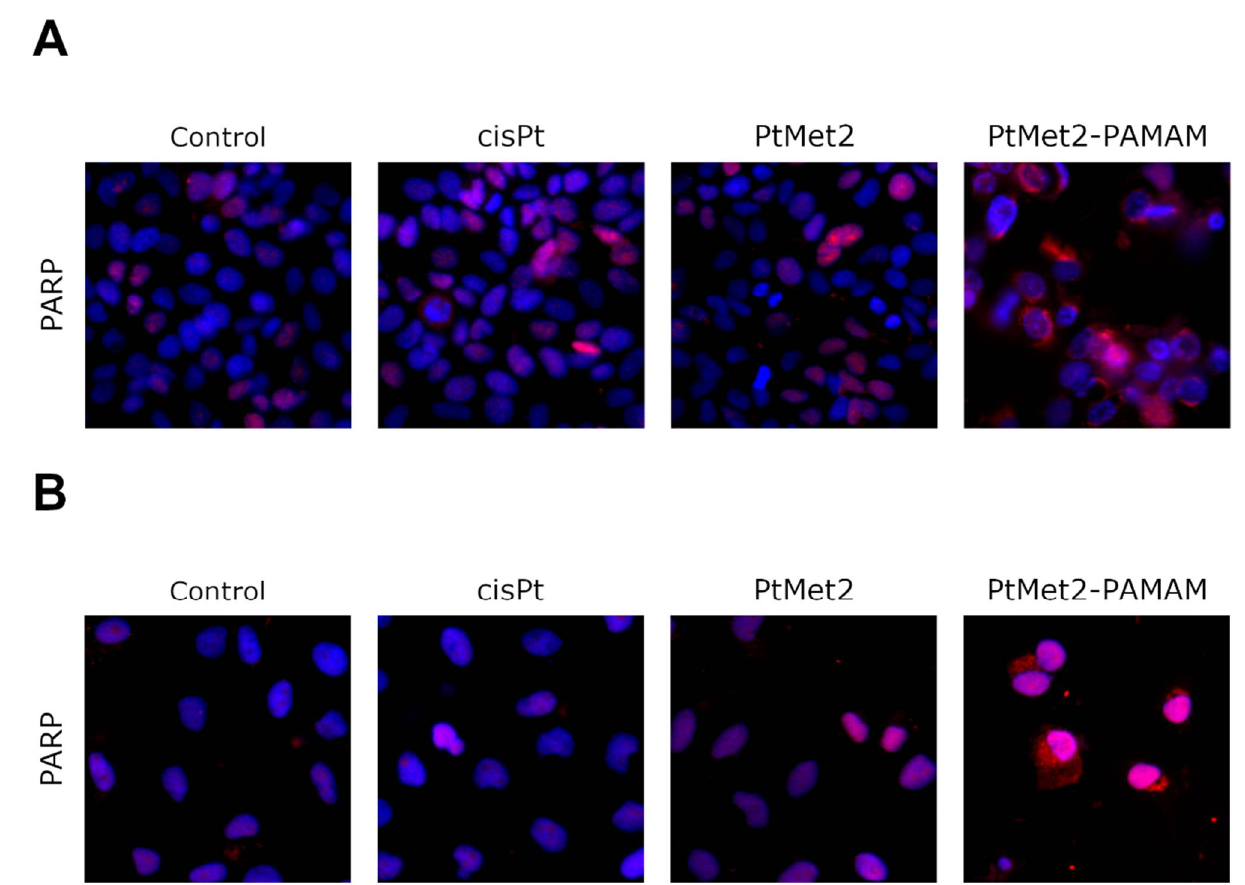
Figure 8. Expression and nuclear translocation of PARP detected by fluorescence microscopy in MCF-7 ( A ) and MDA-MB-231 ( B ) breast cancer cells after treatment with PtMet2, PtMet2–PAMAM, and cisplatin (2.5 µ M all of them) for 24 h. Representative photographs are shown.